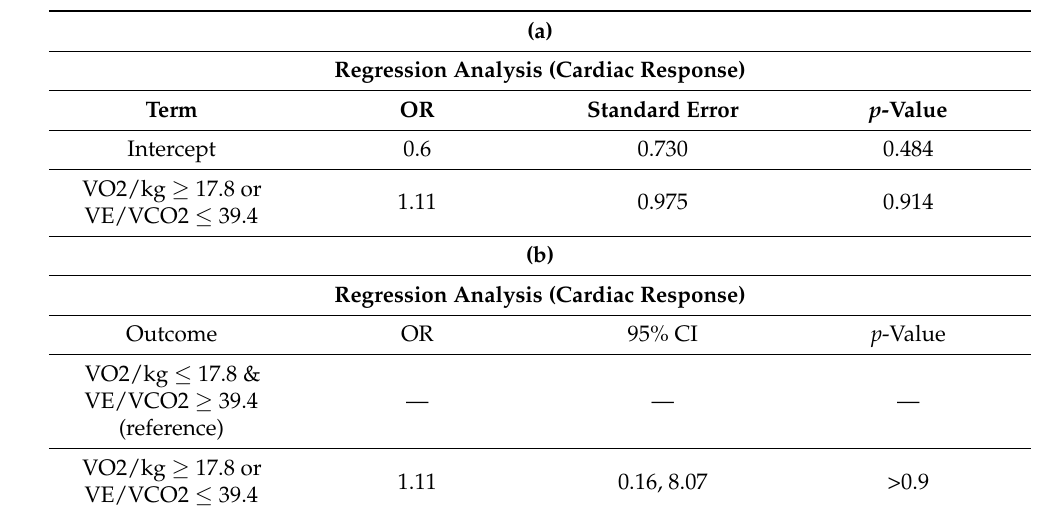
Table 4. ( a ). Logistic regression analysis of cardiac response at one year. ( b ). Logistic regression analysis of cardiac response at one year among patients with high-risk CPET